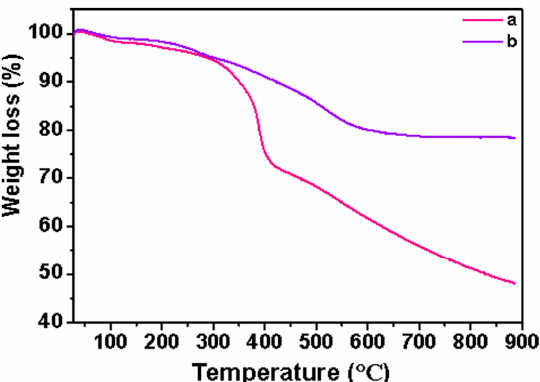
Figure 6. Thermogravimetric analysis curves of the SiO 2 @PMDA-Si-Tb-phen ( a ) and SiO 2 @PMDA-Si-Tb-phen@SiO 2 ( b ).